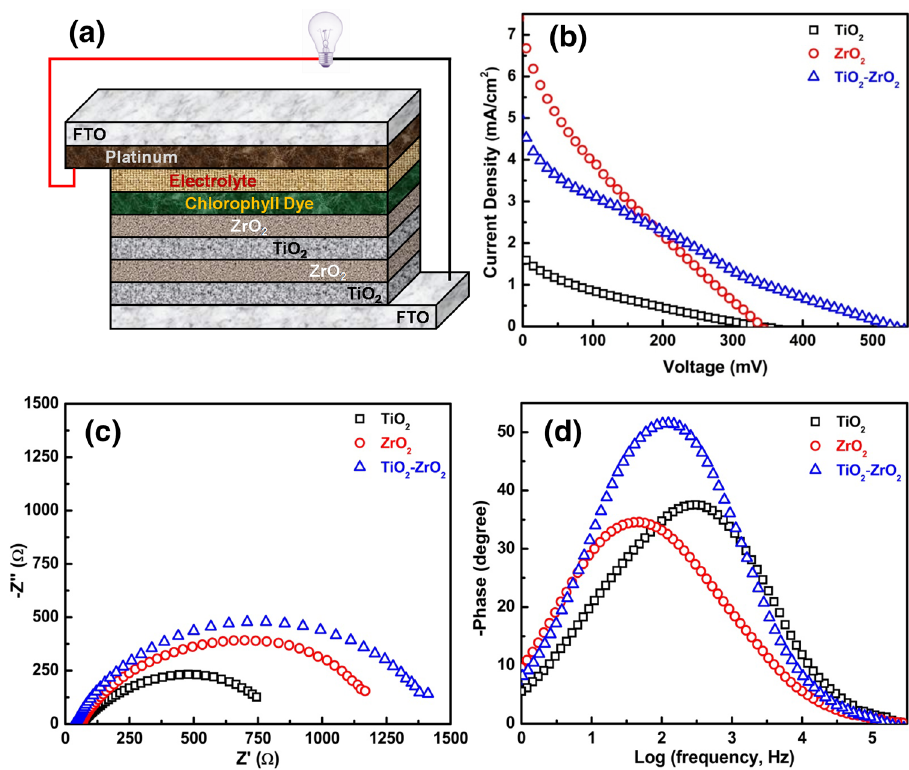
Fig. 4 a Schematic of device, b current density–voltage ( J – V ) characteristics curve, c Nyquist plot and d bode phase plot for TiO 2 (open square), ZrO 2 (open circle), TiO 2 –ZrO 2 (open triangle) photoanodes-sensitized with natural